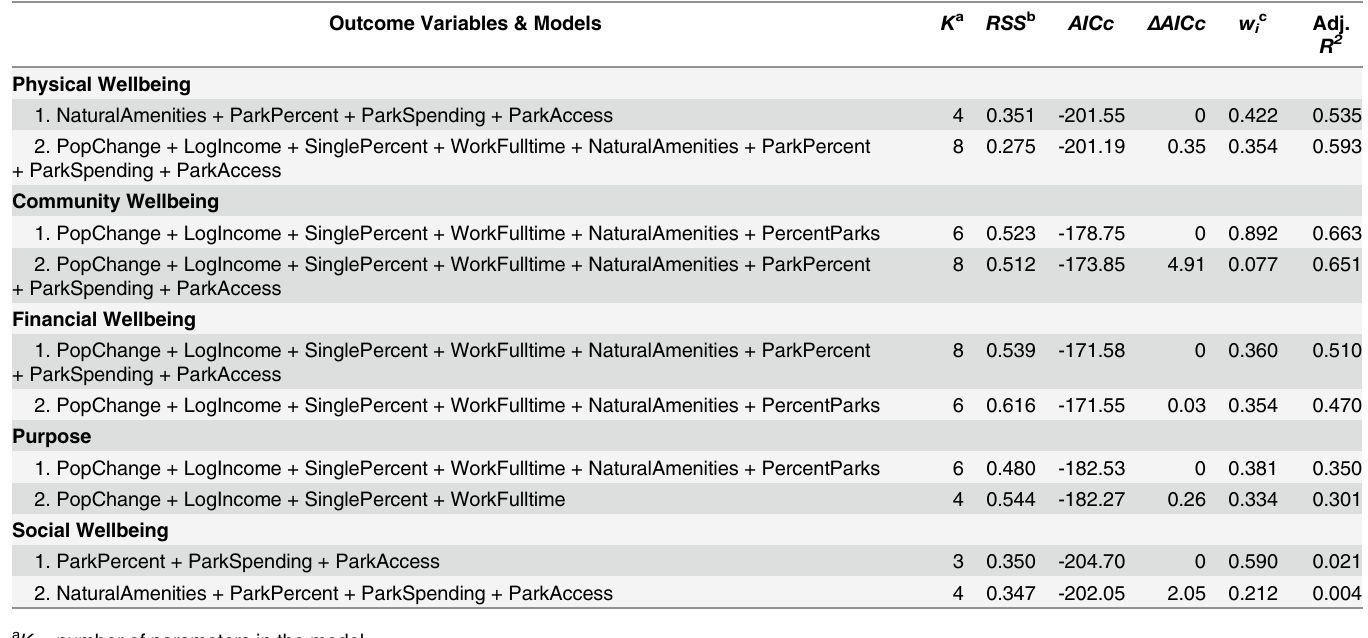
Table 5. Top Two Models Predicting each Subdomain of Wellbeing in U.S. Cities (n =